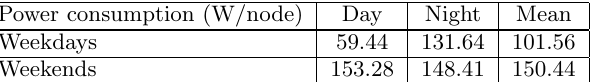
Figure 9: Power consumption of the Reims site. Daytime is in white, while nights and weekends are in gray. Power consumption (W/node)